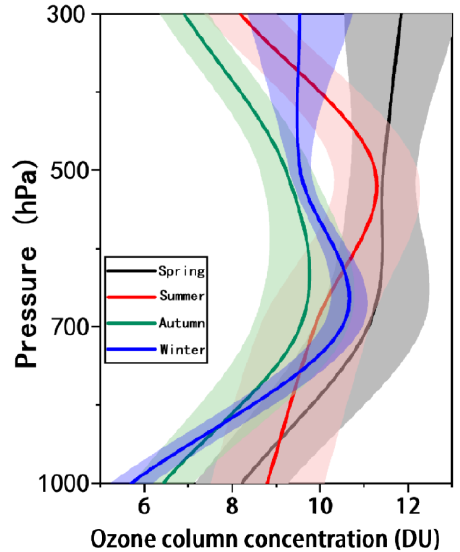
Figure 4. Seasonal distribution characteristics of tropospheric ozone profiles in mainland China (shaded areas indicate the standard deviation ranges; spring is March to May, summer is June to August, autumn is September to November, and winter is December to February).